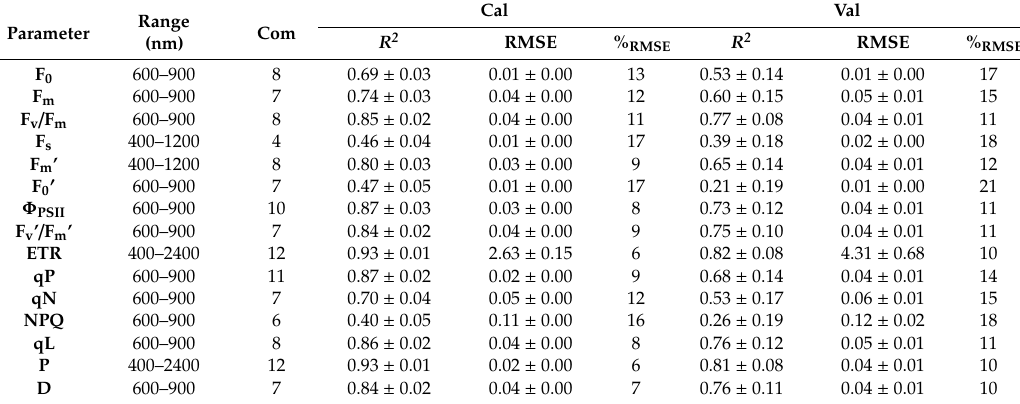
Table 1. Range of wavelengths, number of components (Com), model goodness-of-fit ( R 2 ), root mean square error (RMSE), and percent RMSE of the data range (% RMSE ) for calibration (Cal) and validation (Val) data generated using 500 random permutations of the data with 80% used for Cal and 20% used for the Val for the PLSR models predicting chlorophyll a fluorescence parameters from spectra of date palm leaves. Bias outputs are not shown as they were always lower than 0.01 for both Cal and Val. Data are shown as mean ± standard deviation. Parameters: F 0 , minimum fluorescence yield in the dark-adapted state; F m , maximum fluorescence yield in the dark-adapted state; F v / F m , maximum quantum e ffi ciency of PSII photochemistry; F s , steady state fluorescence intensity in light-adapted state; F m ’, maximum fluorescence intensity in the light-adapted state; F 0 (cid:48) , minimum fluorescence intensity in the light-adapted state; Φ PSII , PSII operating e ffi ciency in light conditions; F v ’ / F m ’, maximum e ffi ciency of PSII in light conditions; ETR, electron transport rate ( µ mol m − 2 s − 1 ); qP, photochemical